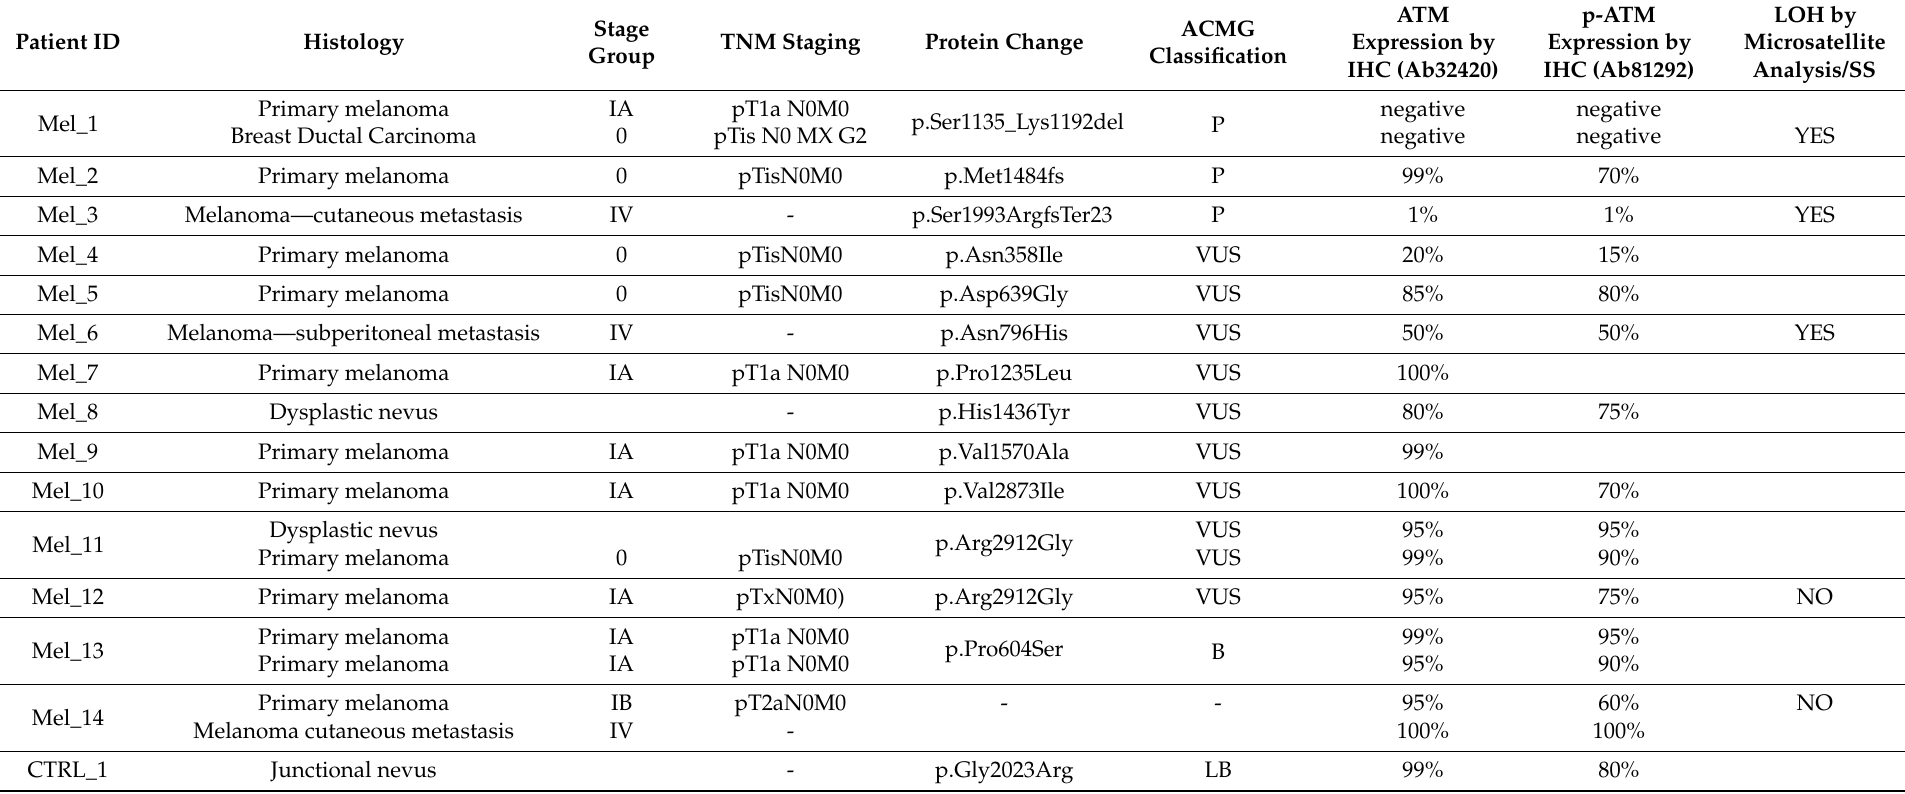
Table 2. Histology, stage, IHC, and LOH